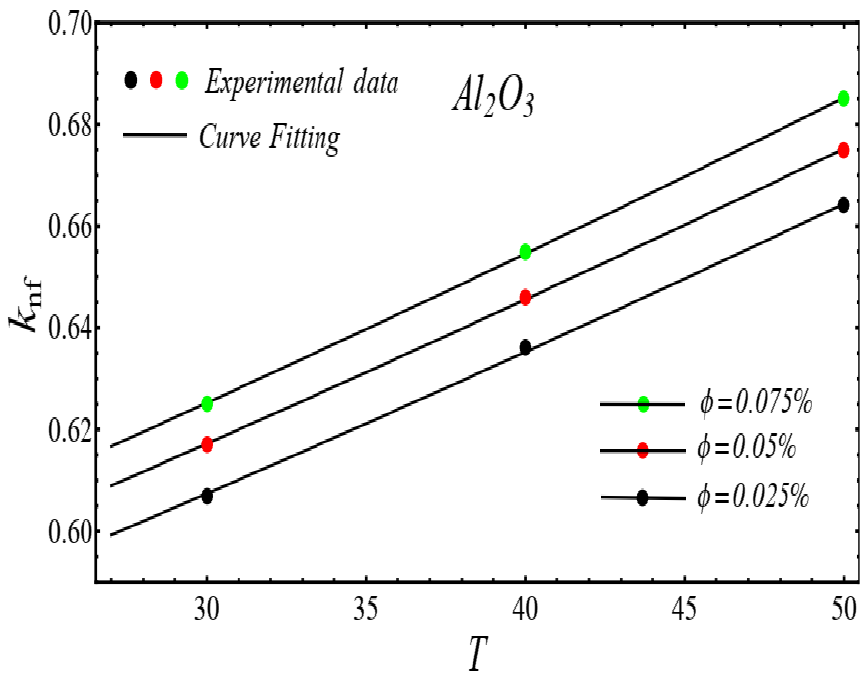
Figure 10. Fitting the Equation (4) for experimental data of Al 2 O 3 /DIW nanofluid at different nanoparticle volume fractions.